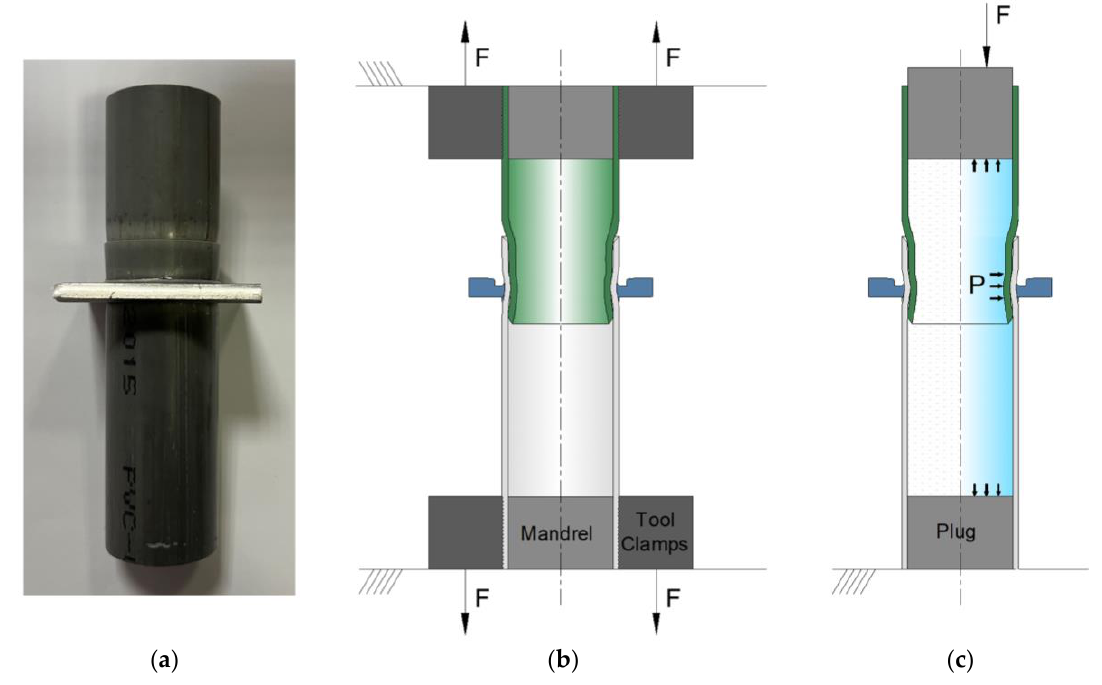
Figure 4. Initial specimen example ( a ) to assess the performance of the mechanical joint to ( b ) pull-out loads and ( c ) leak tightness.